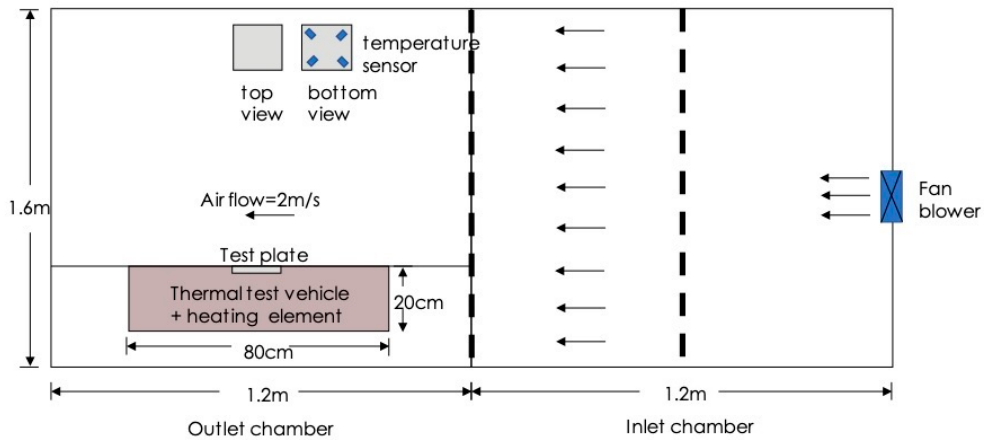
Figure 1. The experimental setup for conducting forced convection.